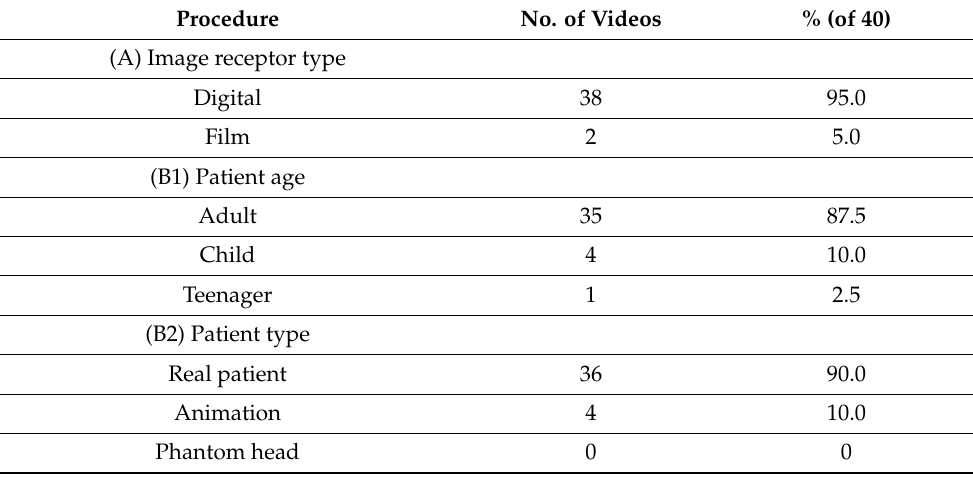
Table 1. Frequency counts of (A) image receptor type, (B) patient type, (C) patient preparation, and (D) machine preparation procedures.